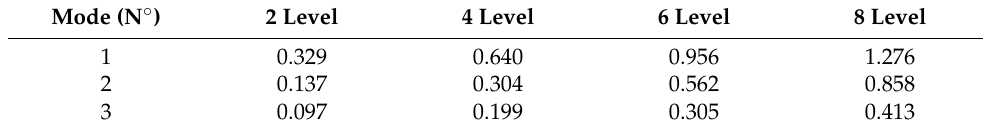
Table 4. Natural periods of the fixed racks at their base analyzed, T n (s).